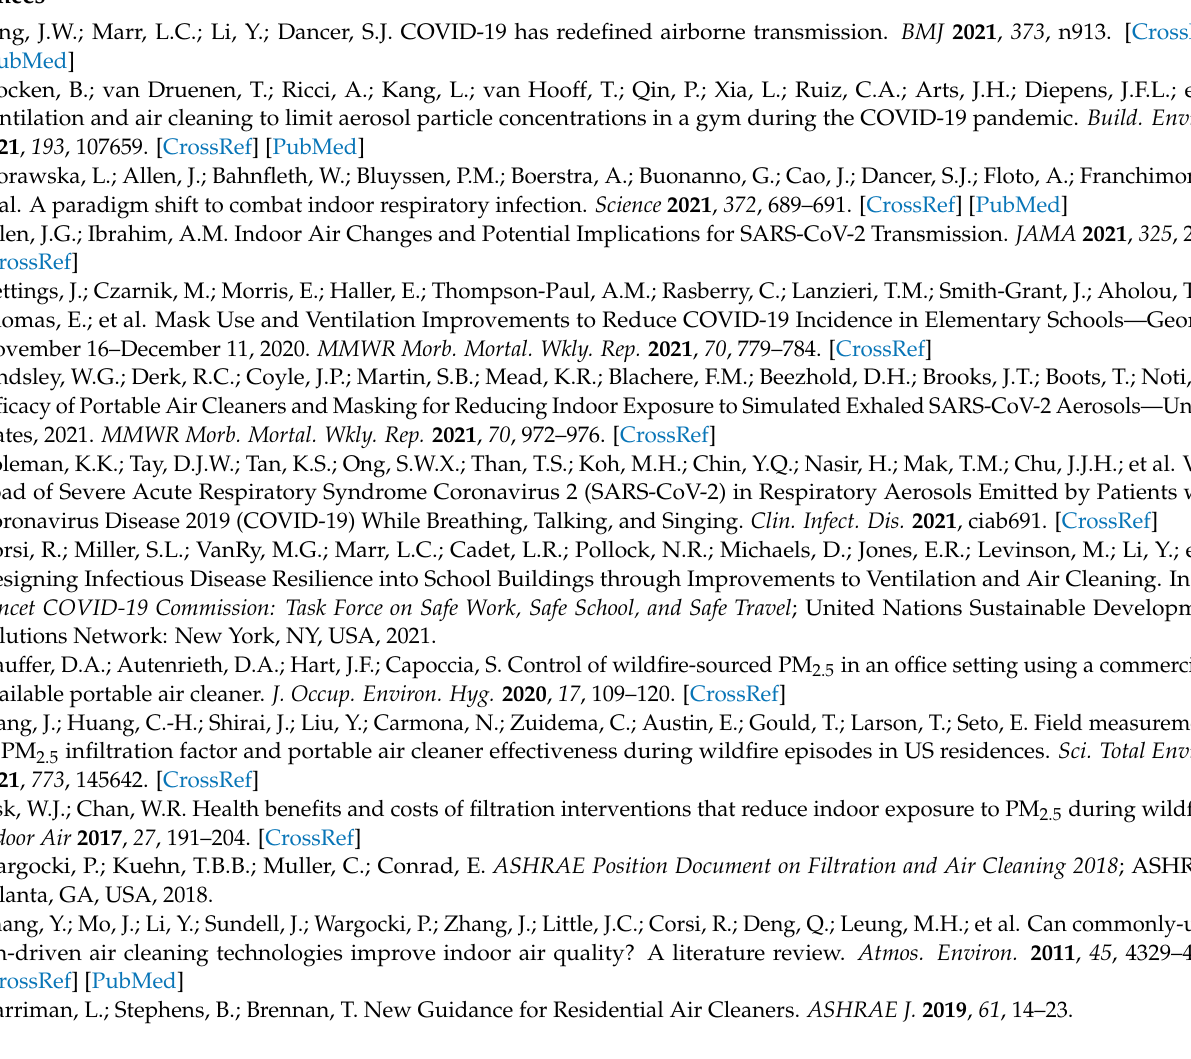
Figure A9. Indoor/outdoor (I/O) ozone concentration ratios over the three experiments performed in the controlled laboratory study averaged over the periods were the air cleaner (AC) was off or on. The error bars represent the standard deviation. Indoor concentrations were measured at the monitoring station in the laboratory as indicated in the schematic of Figure 3. Outdoor concentrations were obtained from hourly monitoring data at the Portland SE Lafayette station from the Oregon Department of Environmental Quality (https://oraqi.deq.state.or.us (accessed on 1 November 2021)).